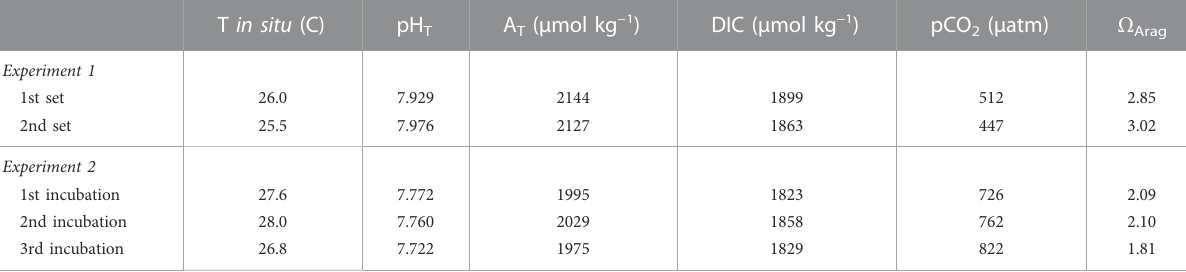
TABLE 1 Initial seawater chemistry conditions for each experiment (mean